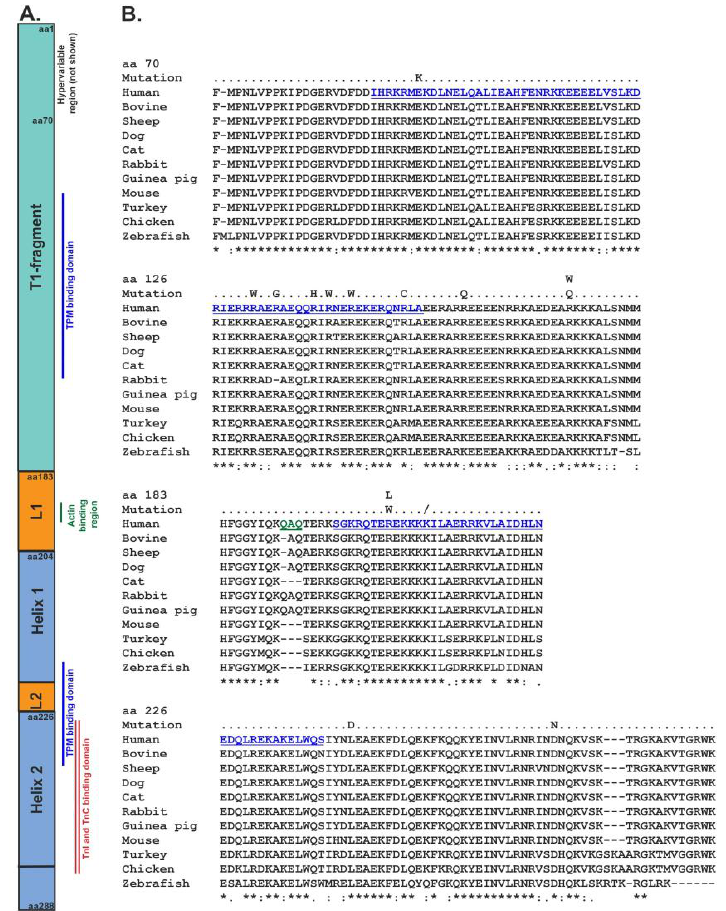
Figure 1. The structure and functional regions of cardiac troponin T alongside the sequence alignment of the regions. ( A ) A schematic image showing the structure of the cTnT protein. The first region of the T1-fragment is known as the hypervariable region and is highly unconserved. Different binding domains of other thin filament proteins are highlighted in the schematic, the blue line indicates the tropomyosin binding domain, green the actin binding domain, and red is the troponin I and troponin C binding domains. L1 and L2 indicate the flexible linkers between helix zone 1 and 2; ( B ) A multiple species alignment of the cTnT protein in comparison to the regions shown in A. Mutations associated with dilated cardiomyopathy are aligned also. The first 70 amino acids of cTnT have been excluded as no mutations are known in this area. Accession numbers for each species are: human